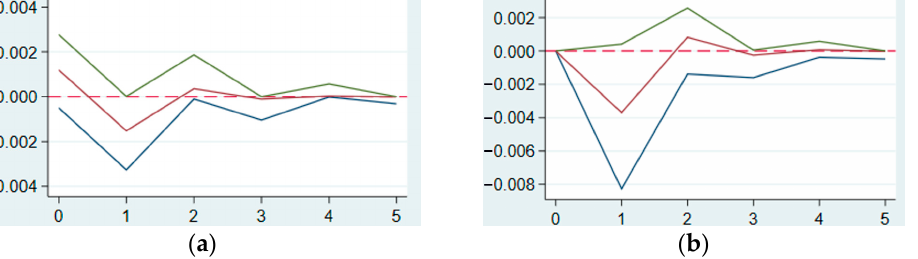
Figure 3. Results of impulse response. ( a ) impulse response from UG to UE. ( b ) impulse response from UE to UG.